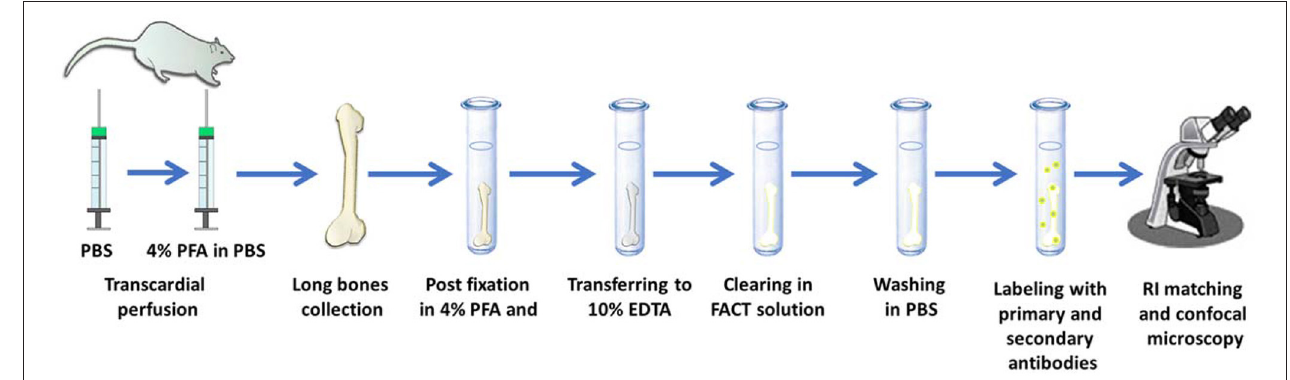
FIGURE 5 | Locating bone marrow mesenchymal stem cells (BM-MSCs) by whole intact bone three-dimensional (3D) imaging based on the FACT method. Using 40mL ice-cold phosphate buffer saline (PBS), transcardial perfusion of rats can be done and followed by 20mL of 4% paraformaldehyde (PFA) in PBS. Then, collected long bones can be post fixed 3 days in 4% PFA solution. Then for demineralization of the bones can be incubated in 10% EDTA in 4 ◦ C. EDTA should be changed daily. Then, the bones can be cleared by the FACT solution (SDS 8% in PBS, pH 7.5). After clearing process and washing of SDS, the tissue can be labeled with specific antibodies for BM-MSCs and then after refractive index (RI) matching can be imaged by confocal